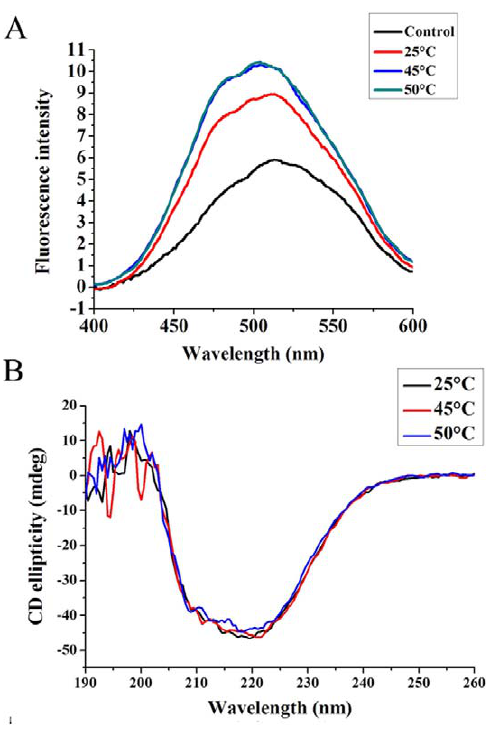
Figure 4. Primary and secondary structure analysis of GreA. (A) The ANS binding experiment shows the hydrophobicity of GreA under normal or heat-shock conditions. ANS alone was set as control; 2 m M GreA was incubated at 25 u C, 45 u C, or 50 u C for 60 min and then mixed with 40 m M ANS. Fluorescence spectra were recorded after incubation for 20 min. (B) CD shows that the secondary structure change of GreA during heat shock was very subtle. The CD ellipticity of GreA was scanned after incubation at 25 u C, 45 u C, or 50 u C for 60 min.